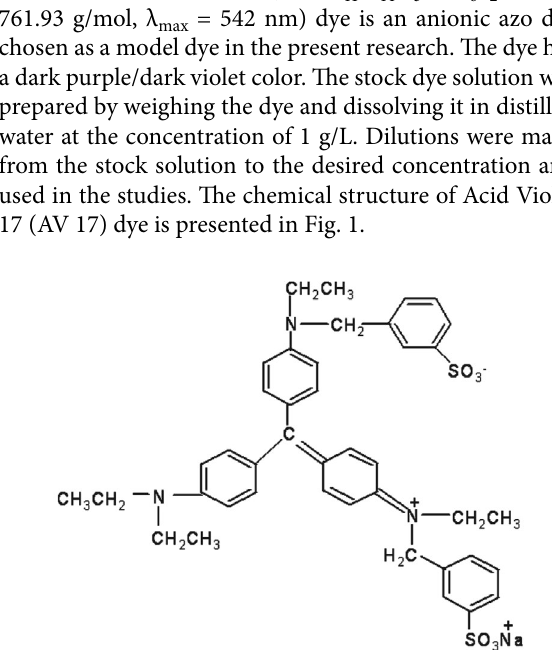
Fig. 1. Chemical Structure of Acid Violet 17.